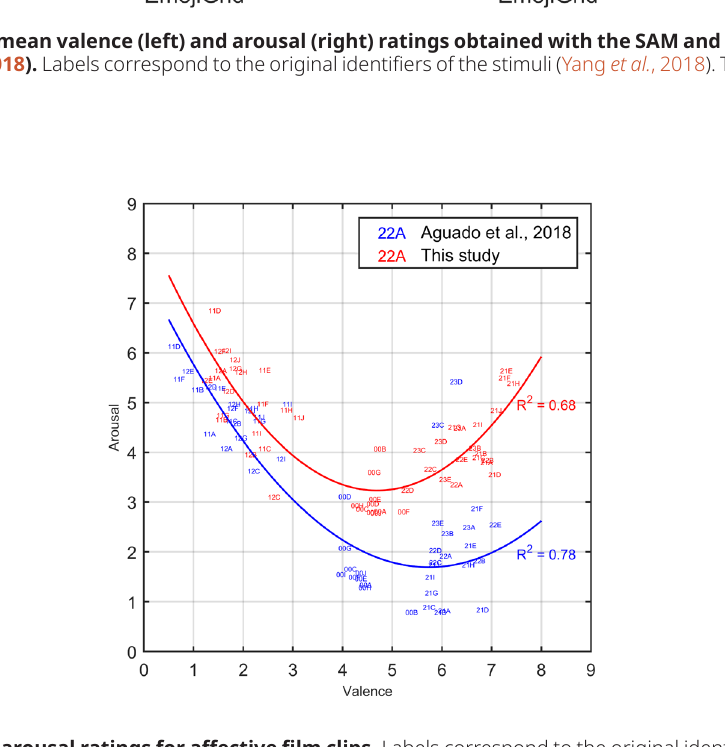
ratings that can be described by a quadratic (U-shaped) relation at the nomothetic (group)